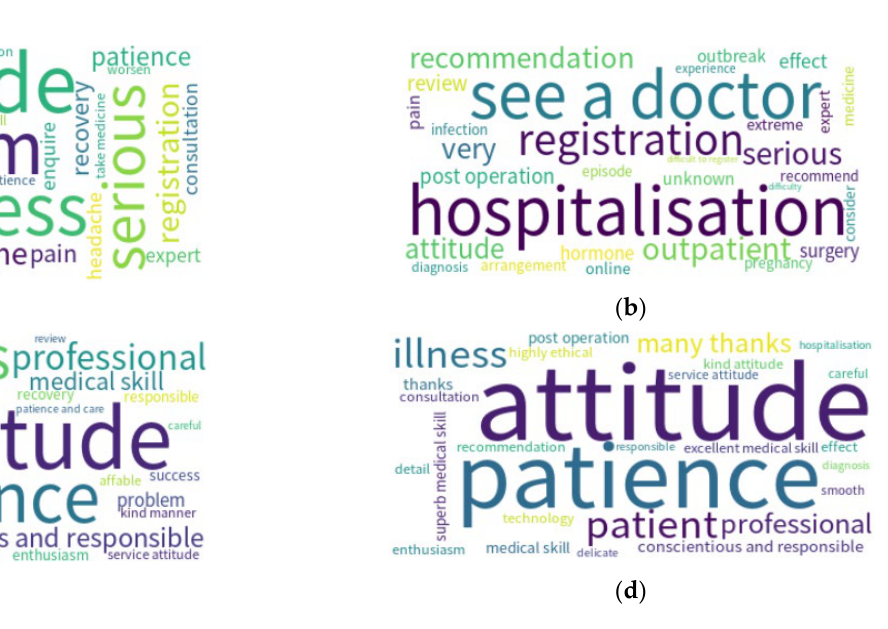
Figure 1. Doctor reviews from Beijing: ( a ) negative before the pandemic, ( b ) negative during the pandemic, ( c ) positive before the pandemic and ( d ) positive during the pandemic.